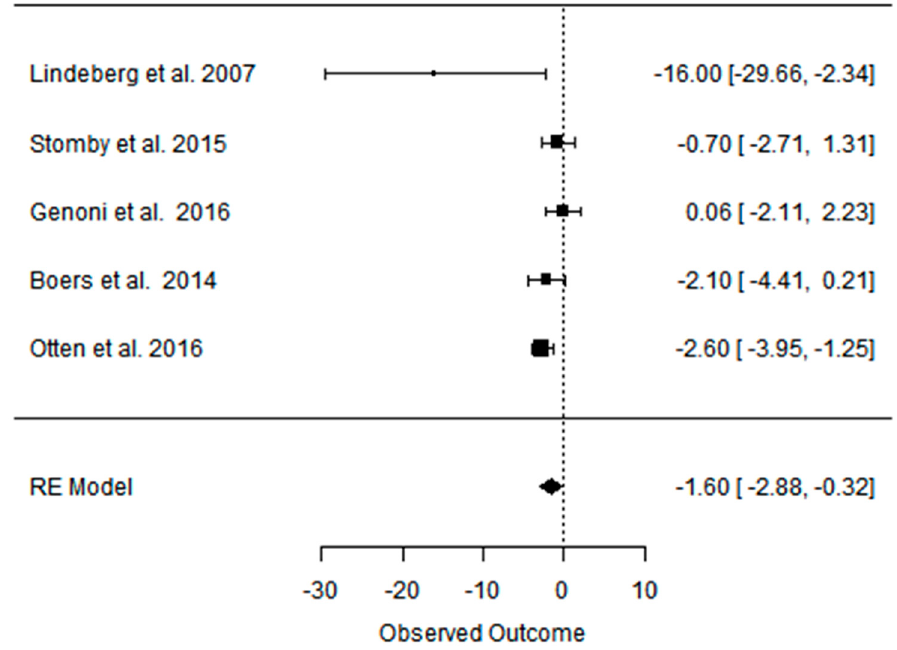
Figure A47. Forest plot of the effect of a PDs on fP insulin (mmol/L) in the short term (weighted mean difference).